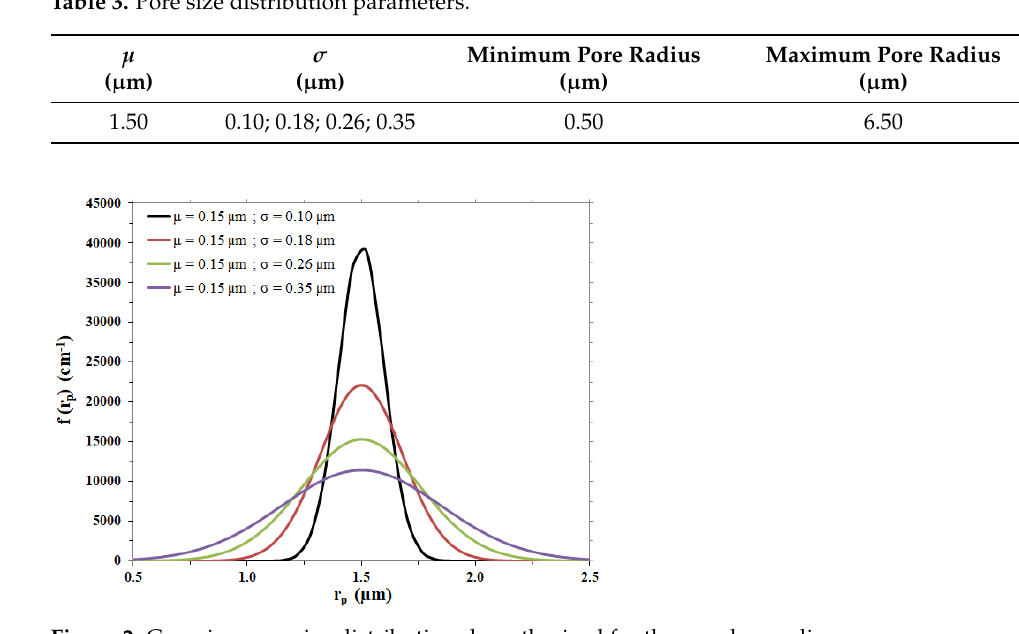
Figure 2. Gaussian pore size distributions hypothesized for the membrane disc.